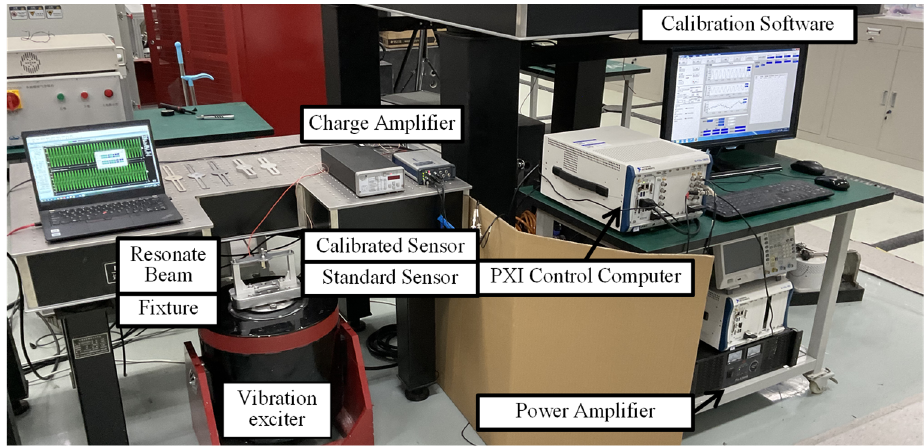
Figure 10. Resonant high-acceleration vibration control system.